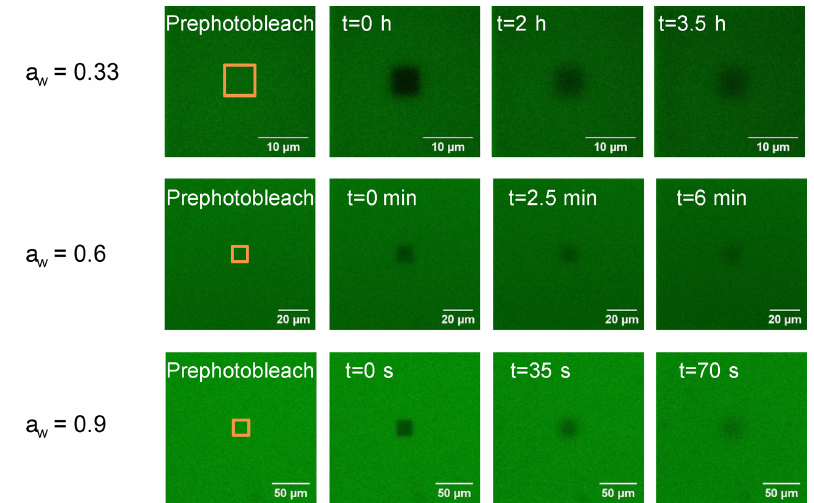
Figure 1. Images of brown limonene SOA films at three different a w (0.33, 0.6, and 0.9) recorded during a rectangular fluorescence recovery after photobleaching (rFRAP) experiment. Times shown in each panel correspond to times after photobleaching. The orange rectangles depict the area to be